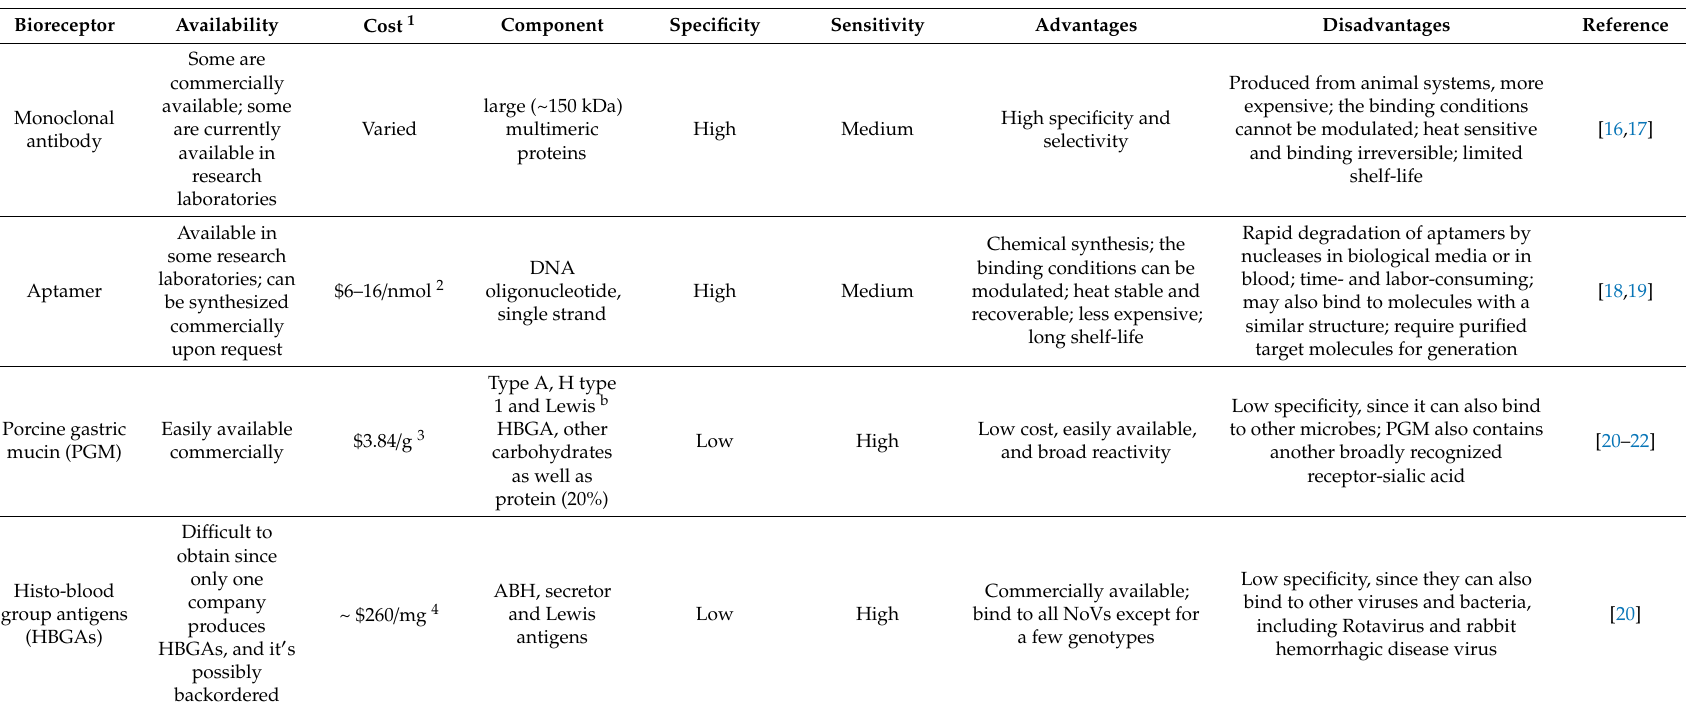
Table 2. Comparison of bio-recognition elements for HuNoV